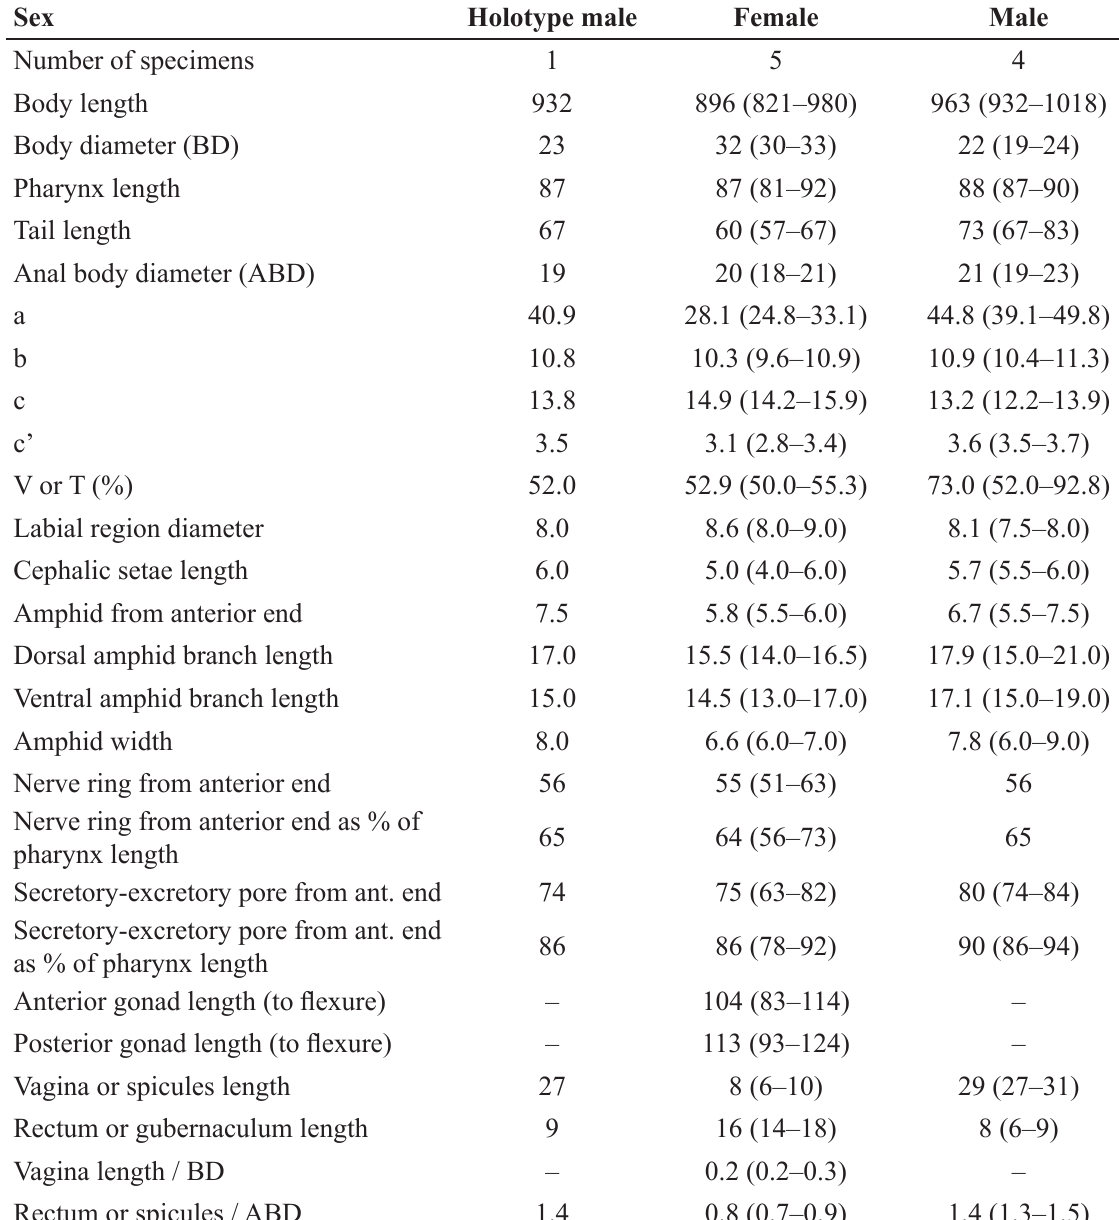
Table 1. Measurements (in µm) of Diplopeltoides suecicus sp. nov., presented as mean and